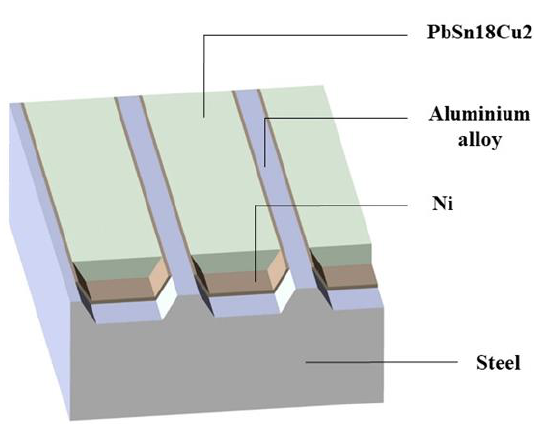
Figure 4. Structure diagram of the sliding bearing.